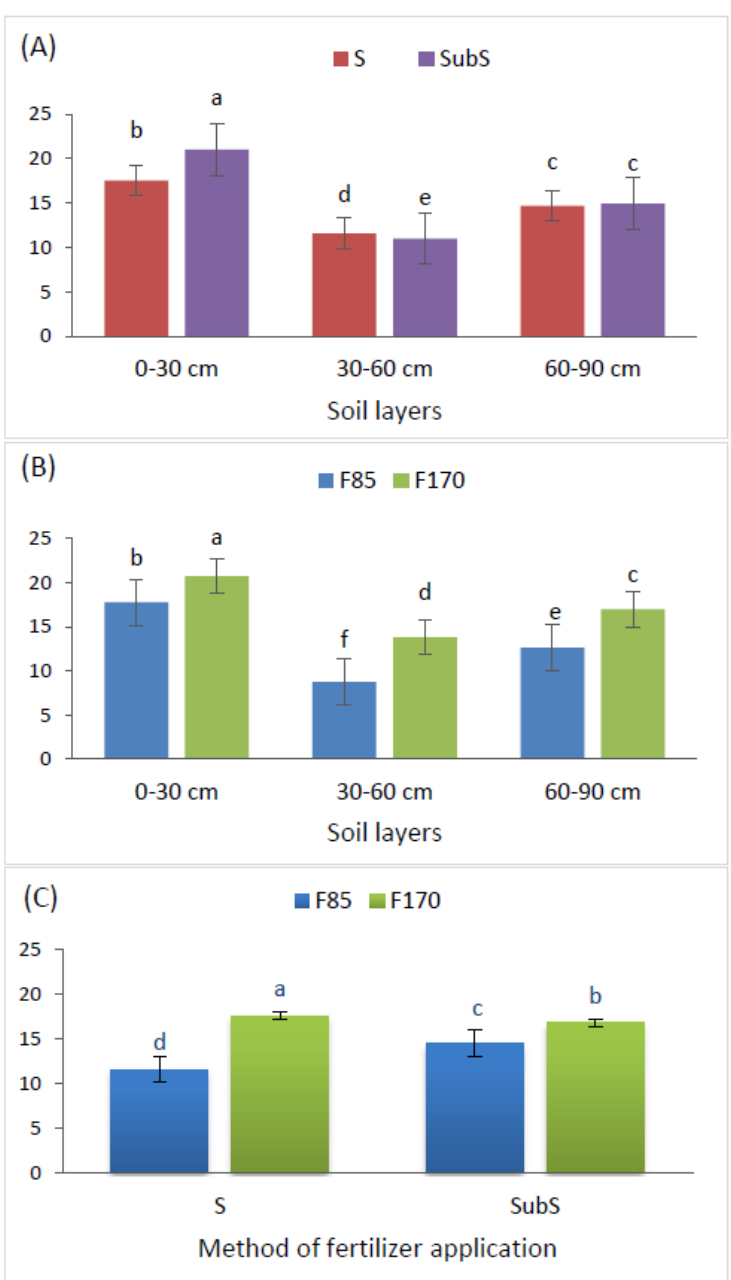
Figure 3. Effect of the interaction of the experimental factors on the soil content of available P [mg · kg − 1 ]: ( A ) Method of fertilizer application × soil layer; ( B ) Fertilizer dose × soil layer; ( C ) Method of fertilizer application × fertilizer dose (S—Surface fertilizer application, SubS—Subsurface fertilizer application; F85—fertilizer dose 85 kg NPKS · ha − 1 ; F170—fertilizer dose 170 kg NPKS · ha − 1 ); different letters indicate significant difference ( p = 0.05).